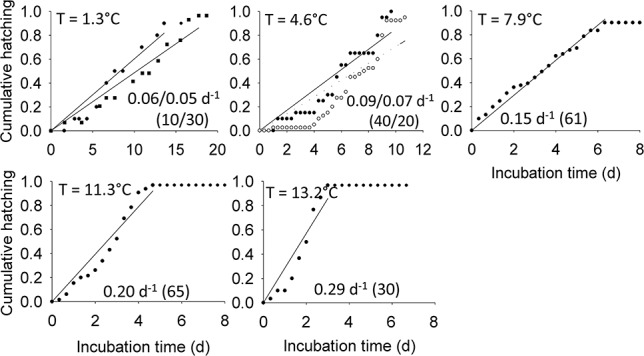

Oithona similis. Cumulative hatching (ratio) as a function of temperature (T) at five different temperatures, with the lines representing a linear model of its increase over time. The hatching rate (slope of linear model, d−1) and number of individuals incubated (n) are given for each incubation. Different symbols indicate replicate experiments. Open circles and dashed lines are used for experiments on egg sacs alone, while black circles and squares and full lines are used for replicates of experiments with egg sacs attached to females. Note the different incubation times (x-axis).